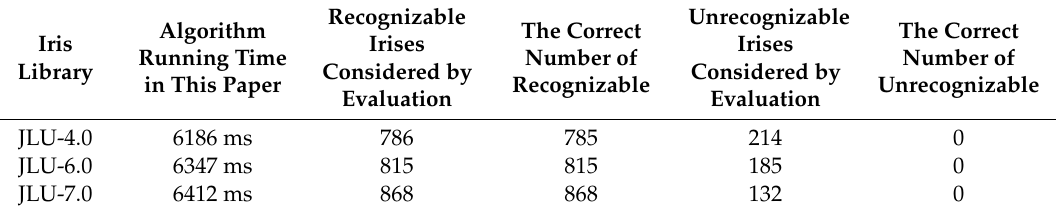
Table 18. The results of the time operation experiment.